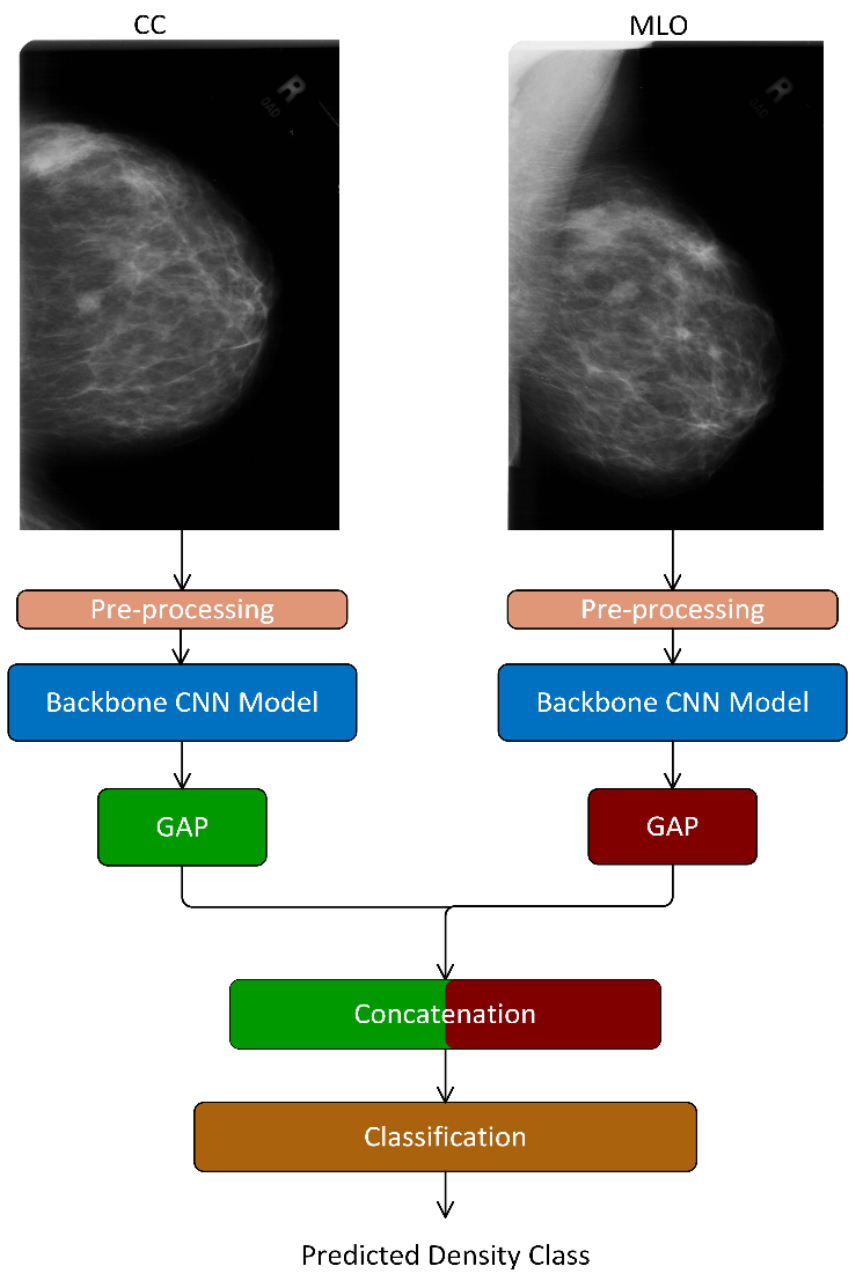
Figure 2. Proposed density classification system. GAP stands for global average pool.